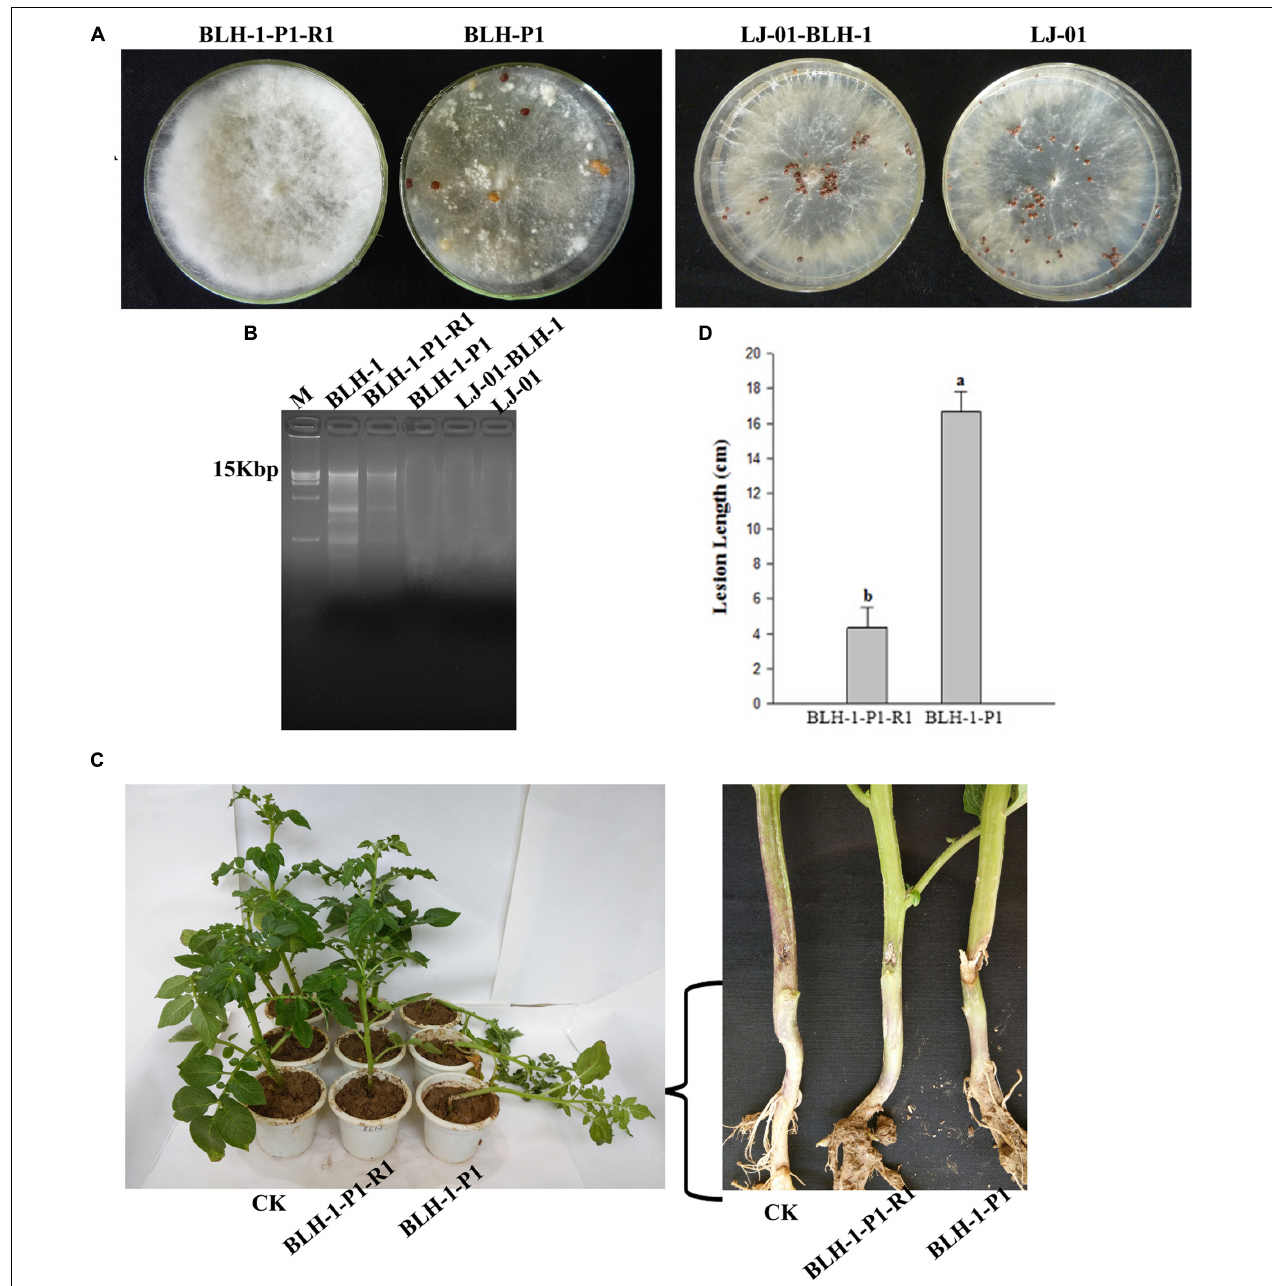
FIGURE 5 | Comparison of the biological characteristics between the recipient derivative isolates and their parental strains. (A) Fungal colony morphology and sclerotia formation of strains BLH-1-P1, LJ-01, BLH-1-P1-R1 and BLH-01-BLH-1, the latter of which were derived from the colony margins of the recipient strains BLH-1-P1 and LJ-01, respectively. These strains were grown on PDA at 27 ◦ C for 14 days. (B) The results of dsRNA detection of the four strains based on 1% agarose gel electrophoresis analysis. (C) Virulence tests of the dsRNA-reobtaining strain BLH-1-P1-R1 and the parental dsRNA-free strain BLH-1-P1 on potato ( Solanum tuberosum ). (D) Lesion diameters caused by strains BLH-1-P1-R1 and BLH-1-P1 were measured after inoculation for 5–8 days.